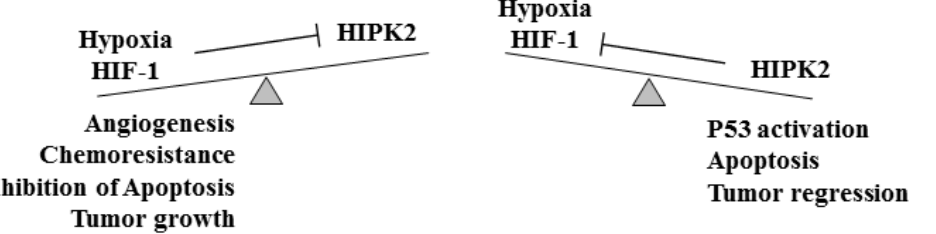
Figure 1. Schematic representation of the balance between hypoxia and HIPK2 in cancer. When hypoxia is activated (( left ) panel) the hypoxia-inducible mechanisms inhibit HIPK2 and the effects of hypoxia (such as angiogenesis, chemoresistance, inhibition of apoptosis, and tumor growth) prevail. When HIPK2 is activated (( right ) panel) the HIF-1-induced molecular mechanisms are inhibited and the antitumor effects (such as p53 activation, activation of apoptosis, and tumor regression) prevail. Thus, HIPK2 silencing increases the xenograft tumor growth and the physiologic rel-